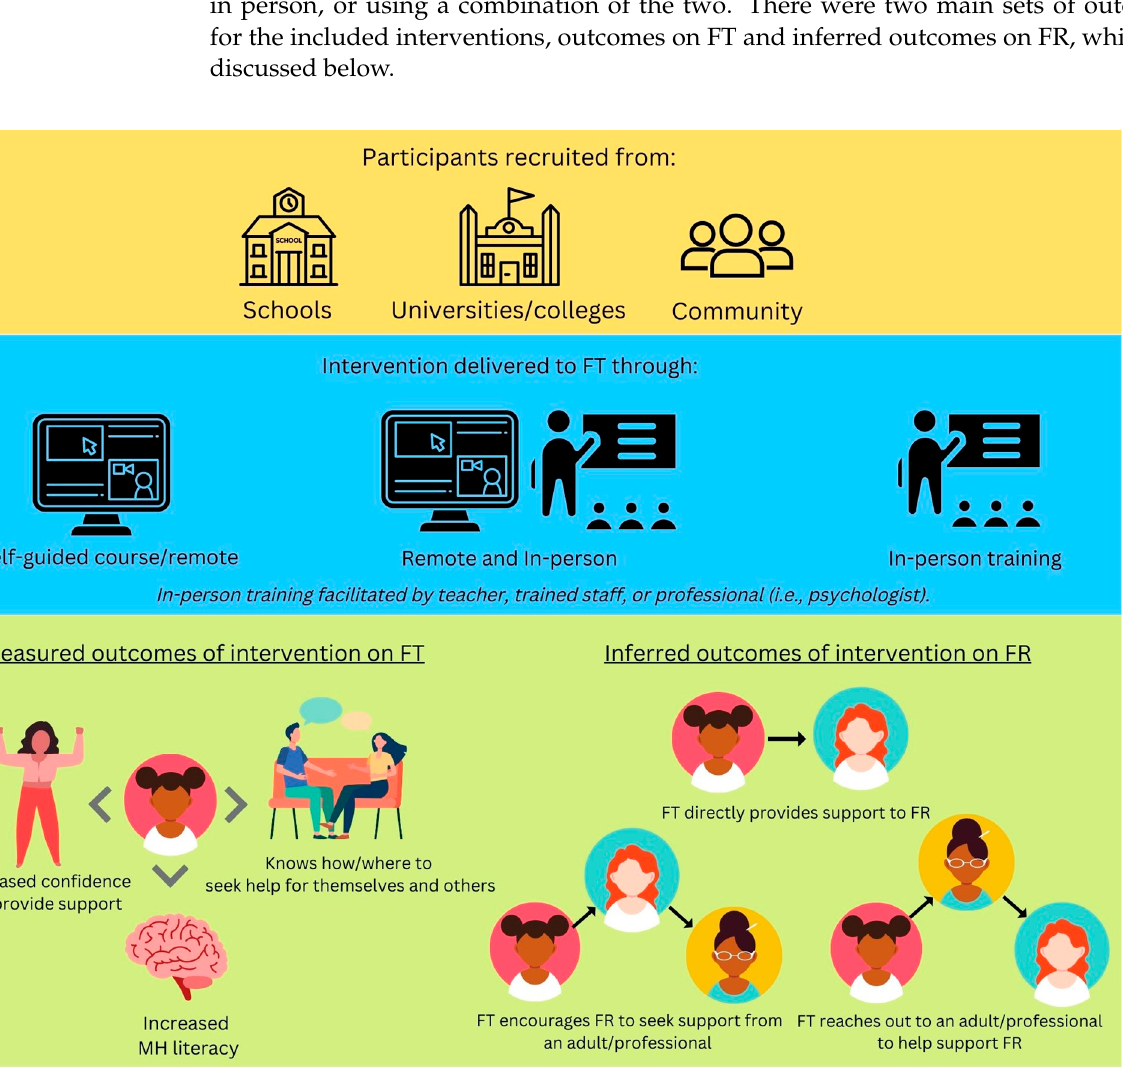
Figure 4. An overview of the studies evaluated in the systematic review, illustrating the typical implementation and results of the included interventions. Note: FT denotes friends trained in the intervention. FR denotes friends receiving support. MH denotes mental health.